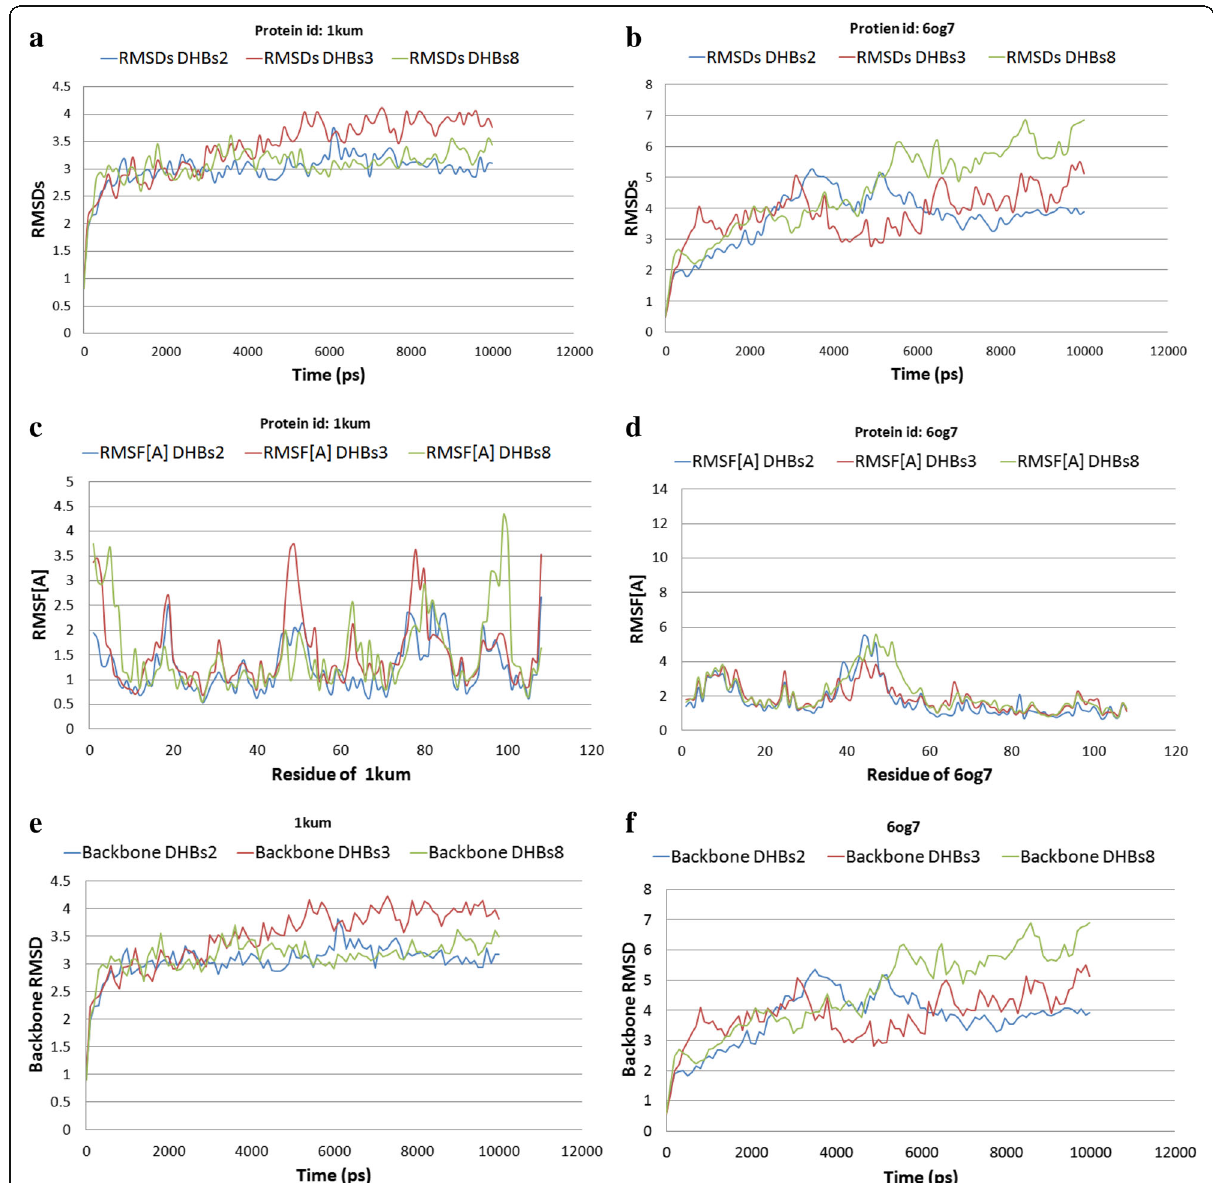
Fig. 3 Analysis of RMSD, RMSF, and Backbone of selected three complexes with protein at 10 ns MD simulations. a Root-mean-square deviation (RMSD) of the 1kum, b RMSD of the 6og7, and c RMSF values of the alpha carbon over the entire simulation, where the ordinate is RMSF (Å) and the abscissa is residue of 1kum. d RMSF (Å) of 6og7. e Backbone of the 1kum. f Backbone of the